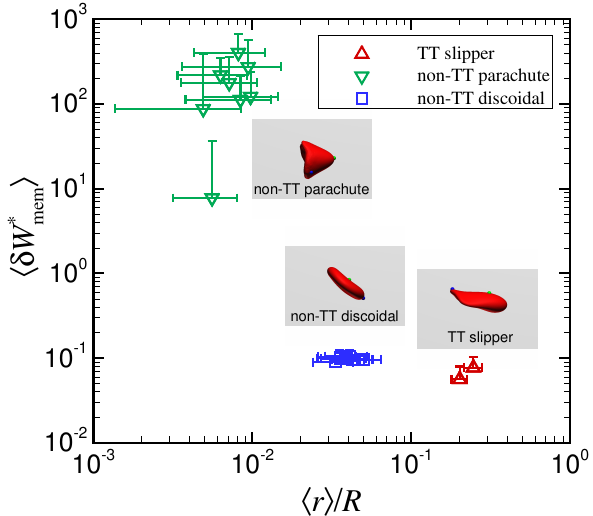
δ W mem as a function of equilibrium (cid:104) (cid:105)